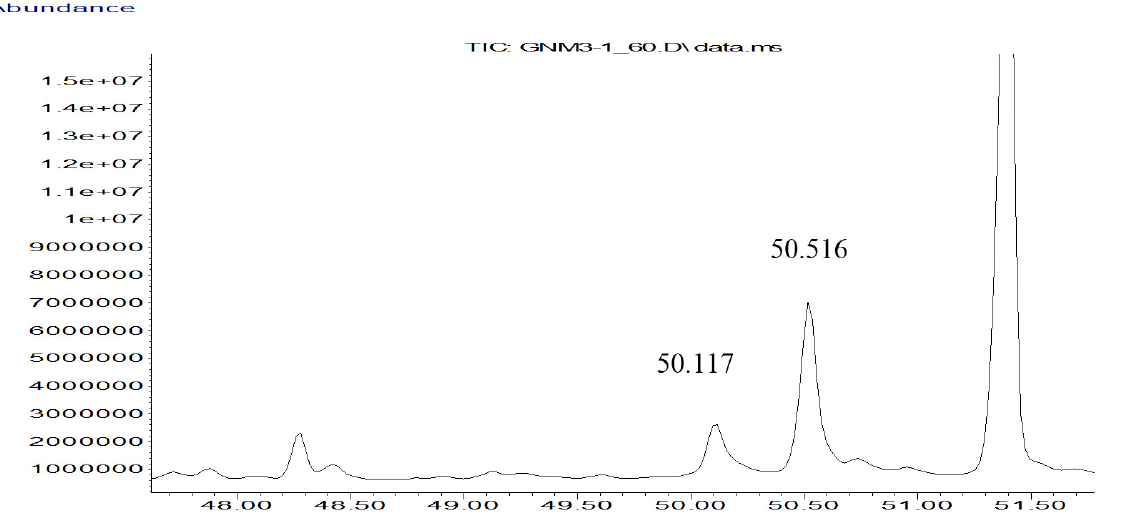
Figure 10. Partial TIC for the grinding surface core (GNM 3-1) showing peaks of interest at RT 50.117 and 50.516.